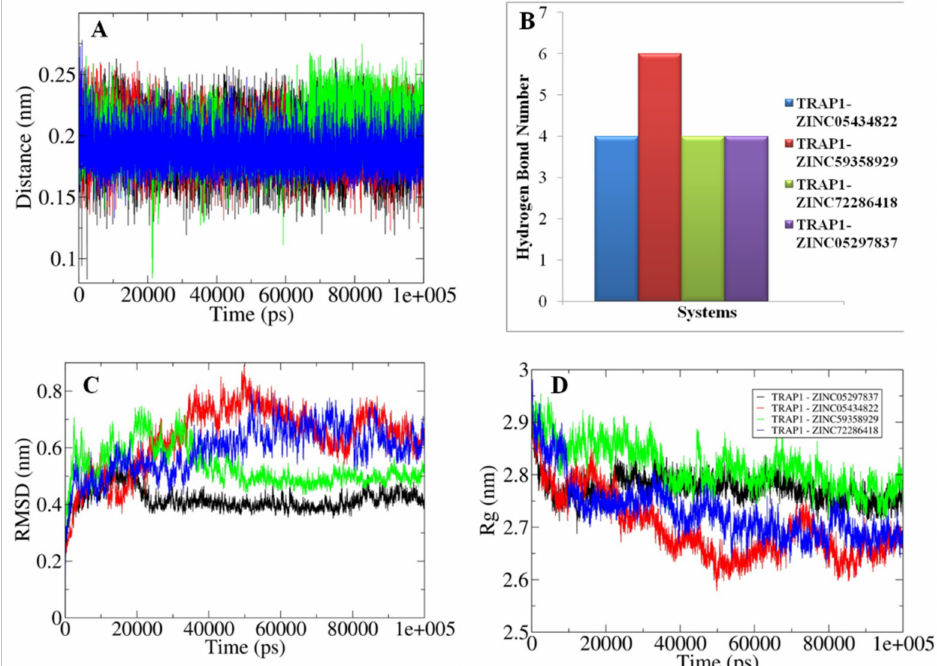
Figure 12. The diagrammatic representation of parameters generated after 100 ns MD simulations with ( A ) Illustrating the changes observed in the calculated distance between the docked TRAP1 and inhibitors. ( B ) Showing the variation observed in the hydrogen bonding patterns. ( C ) Projecting the changes in the RMSD values for different studies docked systems. ( D ) Highlighting the variations in the extent of a radius of gyrations. (Black: TRAP1-ZINC05297837, Red: TRAP1-ZINC05434822, Green: TRAP1-ZINC59358929, Blue: